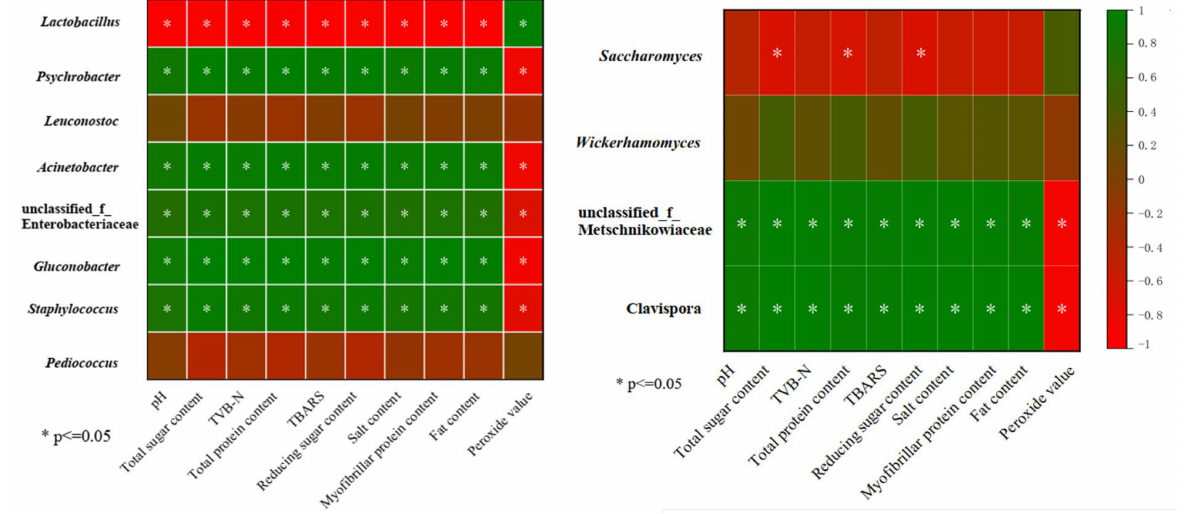
Figure 6. Heatmap of the correlation between physicochemical properties and microorganism genera in vinasse